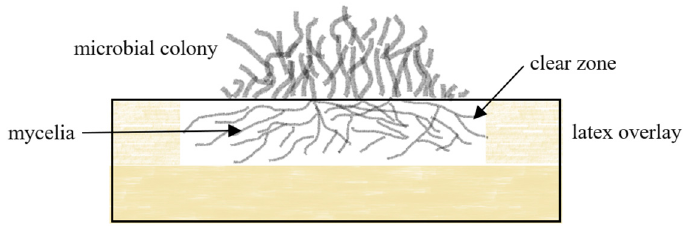
Figure 2. Growth of clear zone formers on NR latex overlay agar. Microbial mycelia penetrate latex agar and releases latex clearing protein enzyme cleaving the polymers double bond.